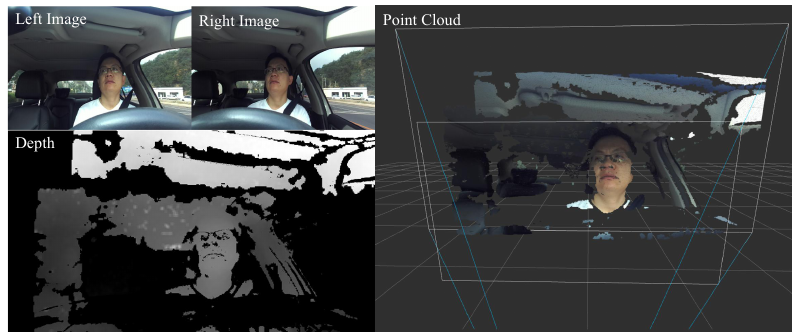
Figure 5. Examples obtained by the stereo